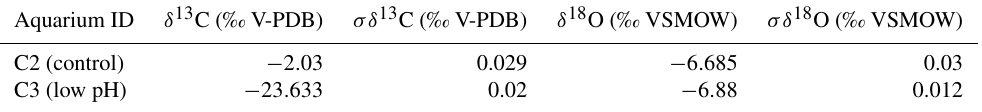
Table B1. Carbon and oxygen isotope composition of artificial seawater from culture experiments at GEOMAR, Kiel, measured in July 2017. C2 refers to the control treatments and C3 represents the acidification treatment. The standard deviation ( σ ) is based on three repeated measurements of each